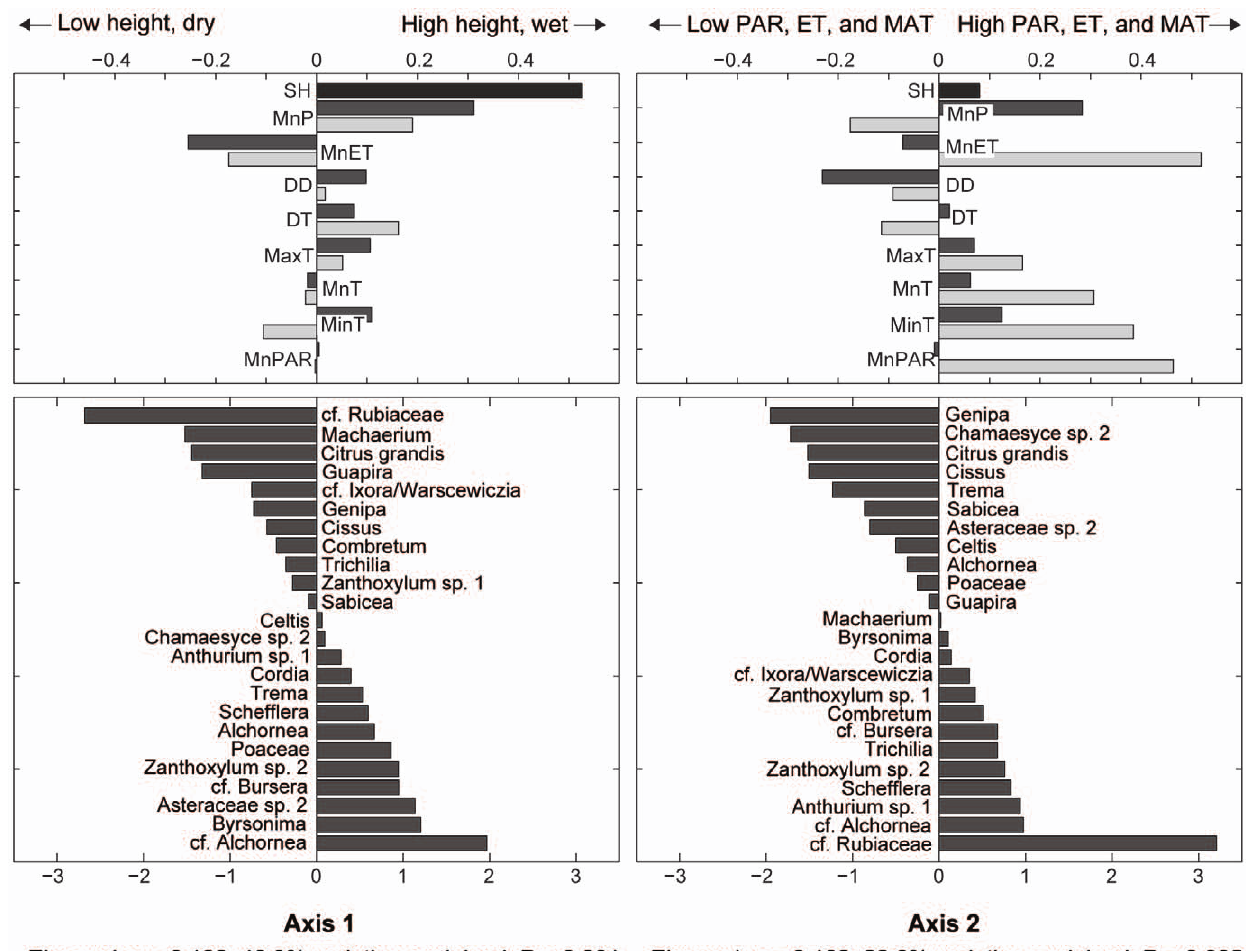
Figure 5. Canonical correspondence analysis of annual non-local pollen influx and current and previous years’ climatic conditions. Environmental and pollen taxon loadings for the first two ordination axes from the CCA of annual non-local pollen influx. Loadings for axis one (top left, bottom left) and loadings for axis two (top right, bottom right). Environmental loadings (top left, top right) and taxon loadings (bottom left, bottom right) are displayed as horizontal bars; the longer the bar, the stronger the correspondence of the variables for each axis. Environmental variables are denoted by the following abbreviations: SH (sampling height), MnP (mean precipitation), MnET (mean evapotranspiration), DD (proportion dry days), DT (diurnal temperature), MaxT (max temperature), MnT (mean daily temperature), MinT (minimum temperature), and MnPAR (mean photosynthetically active radiation). Light bars represent the current years’ climatic conditions; dark bars represent the previous years’ conditions. The first axis is characterized most strongly by variability in sampling height and the previous year’s precipitation. The second axis is characterized by covariance with measures of the current sampling year’s mean ET, PAR and temperature variables. CCA loadings in Table S5.